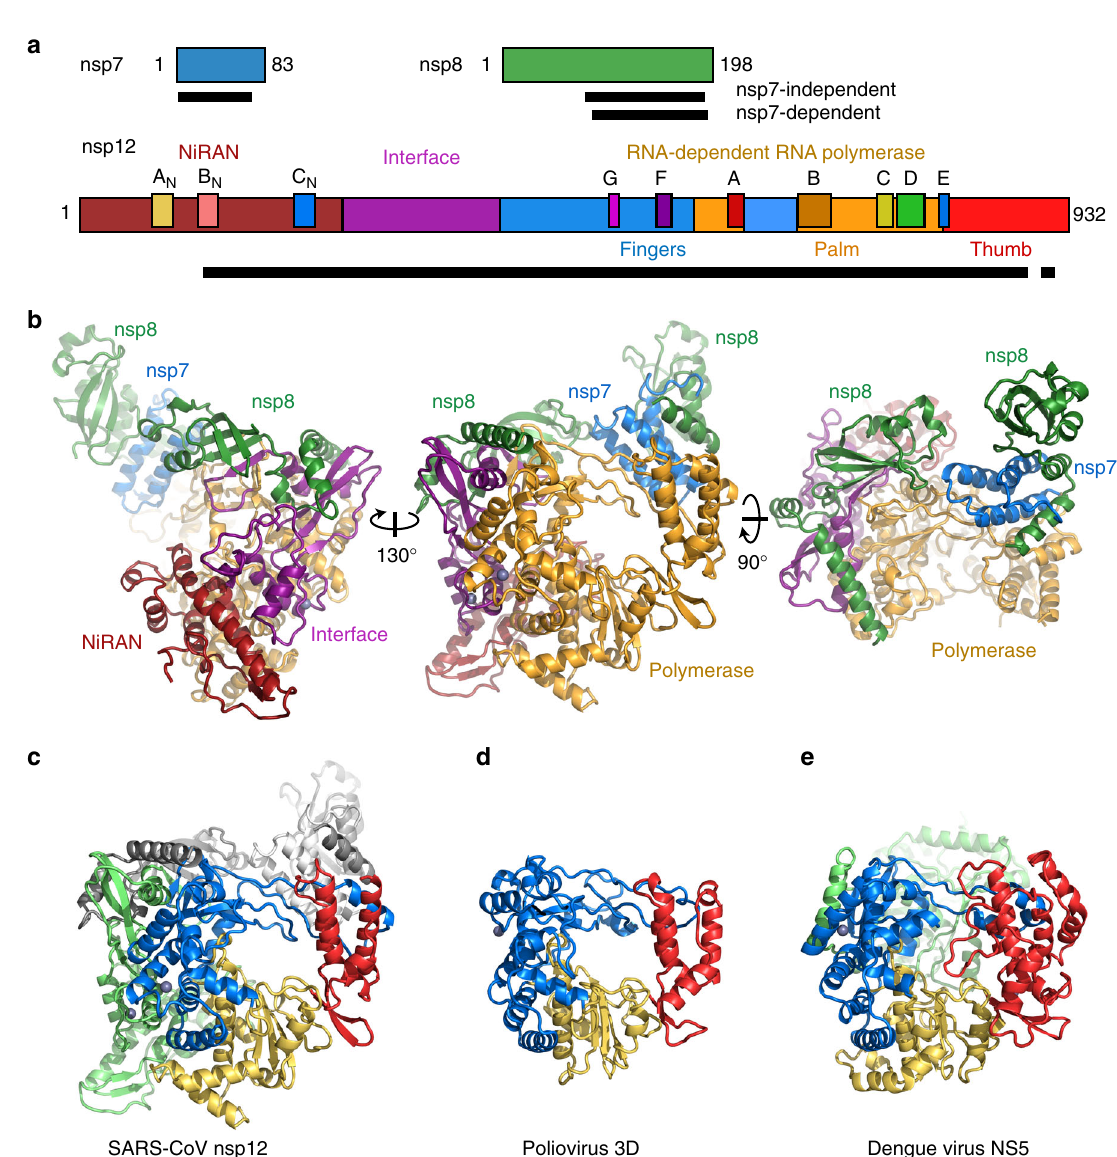
Fig. 1 Structure of SARS-CoV nsp12 bound to nsp7 and nsp8 co-factors. a Diagram of the SARS-CoV nsp7, nsp8, and nsp12 proteins indicating domains, conserved motifs, and the protein regions observed in the structure (black bars) (Supplementary Fig. 3). b SARS-CoV nsp12 contains a large N-terminal extension composed of the NiRAN domain (dark red) and an interface domain (purple) adjacent to the polymerase domain (orange). nsp12 binds to a heterodimer of nsp7 (blue) and nsp8 (green) as well as to a second subunit of nsp8. c – e Comparison of SARS-CoV nsp12 to the polymerase proteins of poliovirus 24 (3OL6.pdb) [10.2210/pdb3OL6/pdb] and dengue virus 55 (4V0R.pdb) [10.2210/pdb4V0R/pdb]. Viral RNA polymerases share an overall structural architecture with fi ngers (blue), palm (yellow), and thumb domains (red). Both SARS-CoV and dengue virus polymerase proteins contain N-terminal extensions colored green. The SARS-CoV nsp7 and nsp8 cofactors are colored in white and gray,